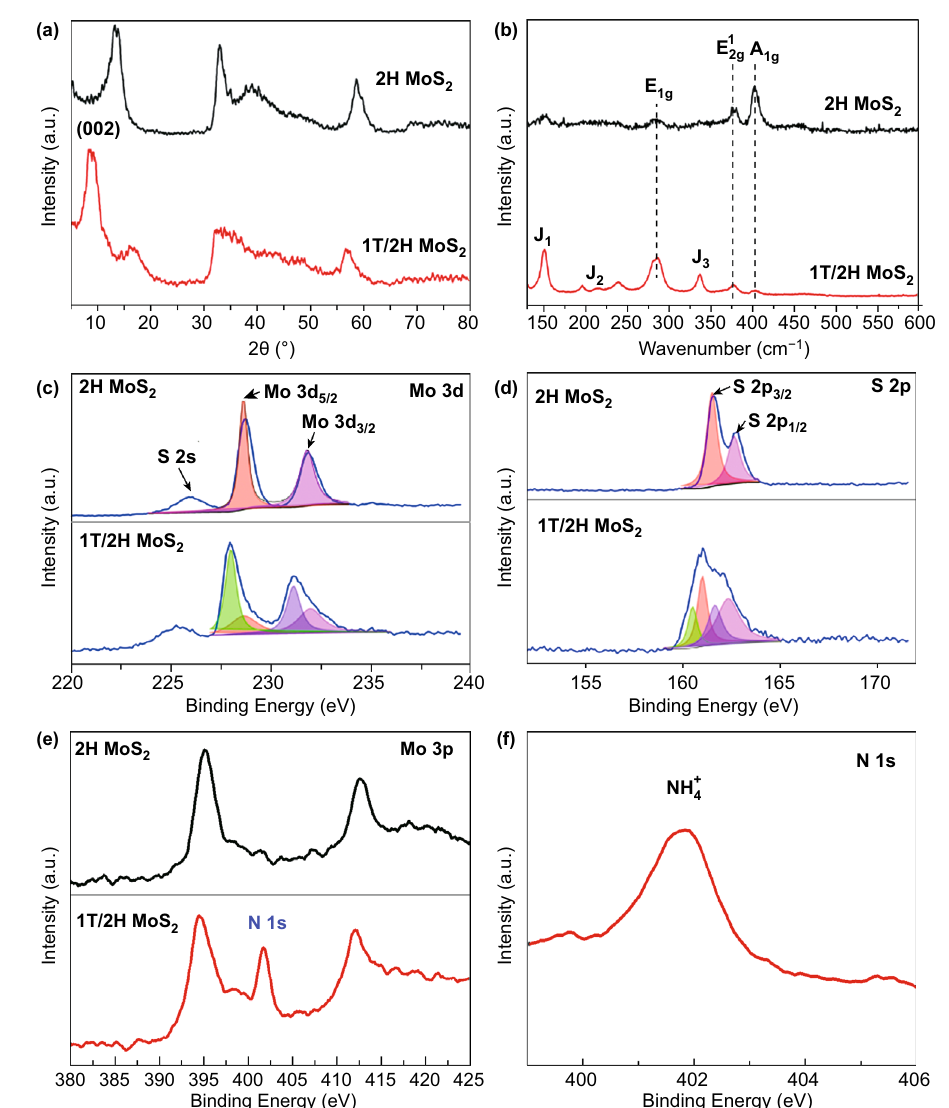
Fig. 1 a XRD patterns, b XPS spectra, c Mo 3d spectra, d S 2p spectra, e Mo 3p spectra of 1T/2H MoS 2 and 2H MoS 2 . f N 1s spectra of 1T/2H